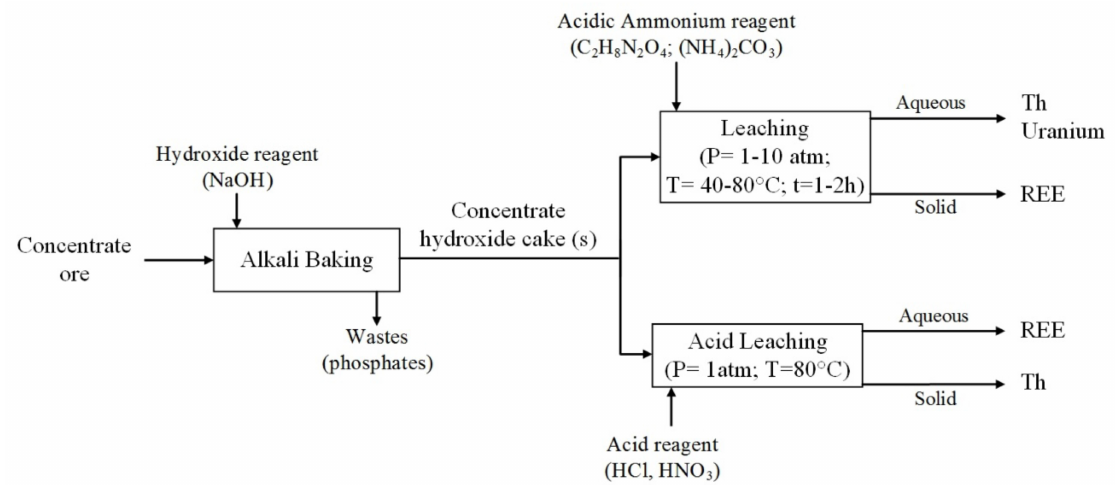
Figure 3. Leaching-cracking approaches for separation of REE from radioactive elements.